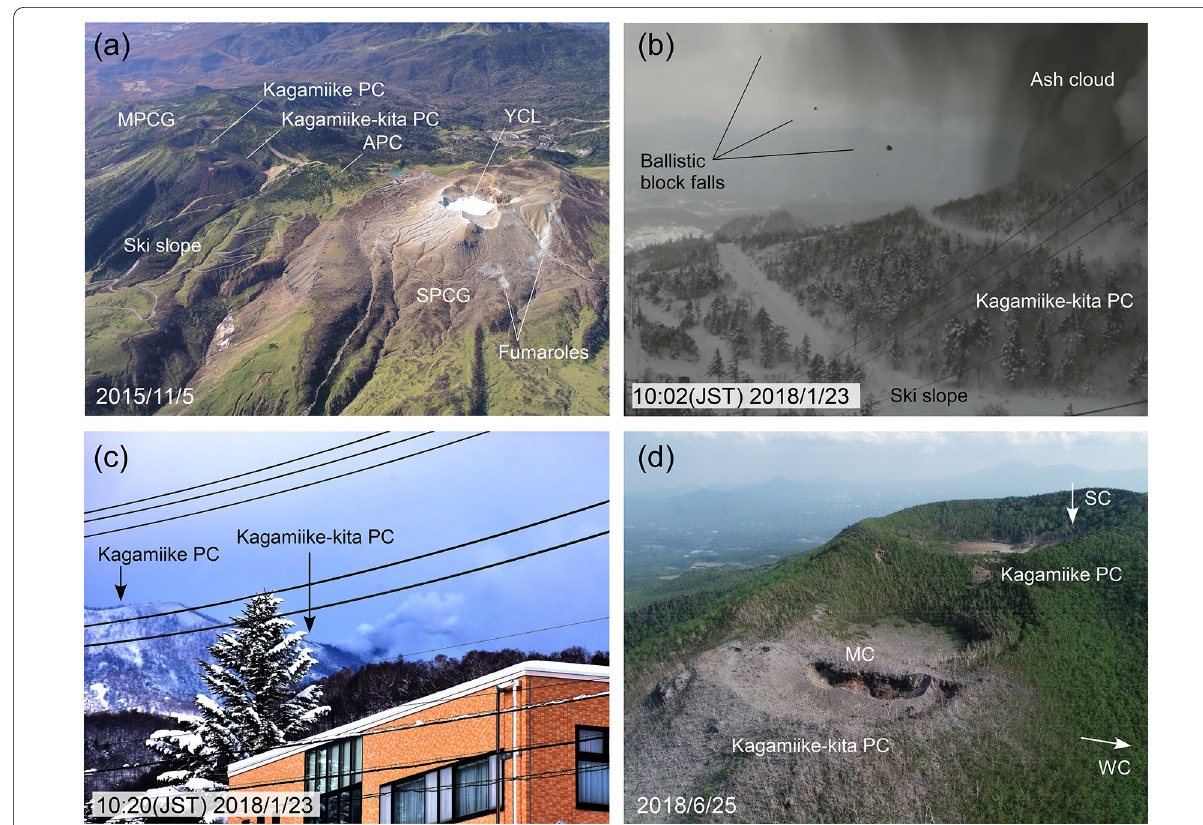
Fig. 2 a Aerial photograph of Kusatsu–Shirane volcano (taken on 5 November 2015). PC pyroclastic cone; MPCG Motoshirane Pyroclastic = = Cone Group; SPCG Shirane Pyroclastic Cone Group; YCL Yugama Crater Lake. b Eruption cloud and ballistic block falls hitting the ski slope, = = (photograph taken by the Kusatsu Tourism Cooperation at 10:02 JST on 23 January 2018). c Weak volcanic cloud rising from the Kagamiike-kita PC at about 10:20 JST on 23 January 2018. d Aerial photograph of the new main crater (MC) at the Kagamiike-kita PC and the south crater (SC) at the Kagamiike PC formed during the 2018 eruption (photograph taken on 25 June 2018). The west crater (WC) is outside the